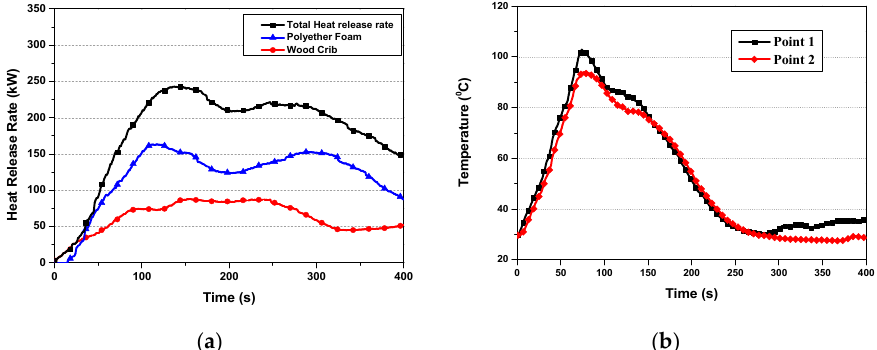
Figure 3. Experiment results: ( a ) heat release rate in the free burn and ( b ) ceiling temperature in the compartment with sprinkler activation.